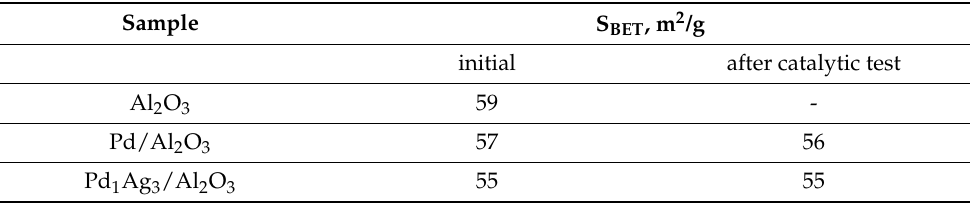
Table 1. Specific surface area of parent Al 2 O 3 and supported Pd/Al 2 O 3 and Pd 1 Ag 3 /Al 2 O 3 catalysts.